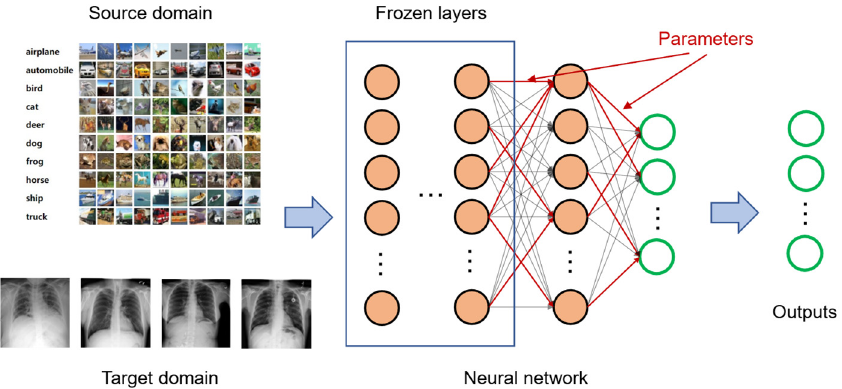
Figure 2. Illustration of transfer learning. When the knowledge is transferred from source domain to the target domain, initial layers are frozen and later layers are trained on the target domain data.